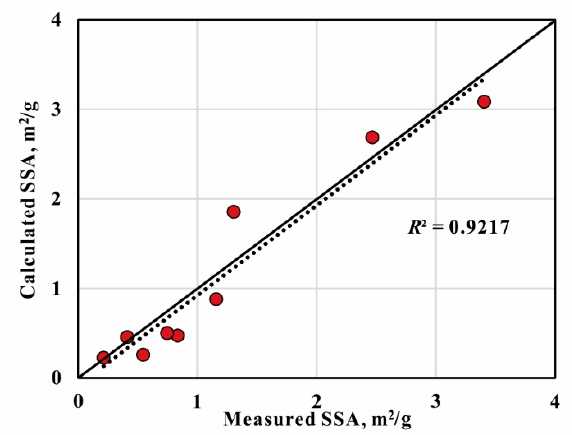
Figure 15. Correlation between measured and calculated SSAs for tight rock samples from the Xujiaweizi Rift. The black solid line represents the best match (1:1 line), and the black dashed line is the fitting line of measured and calculated SSAs. SSA = specific surface area.